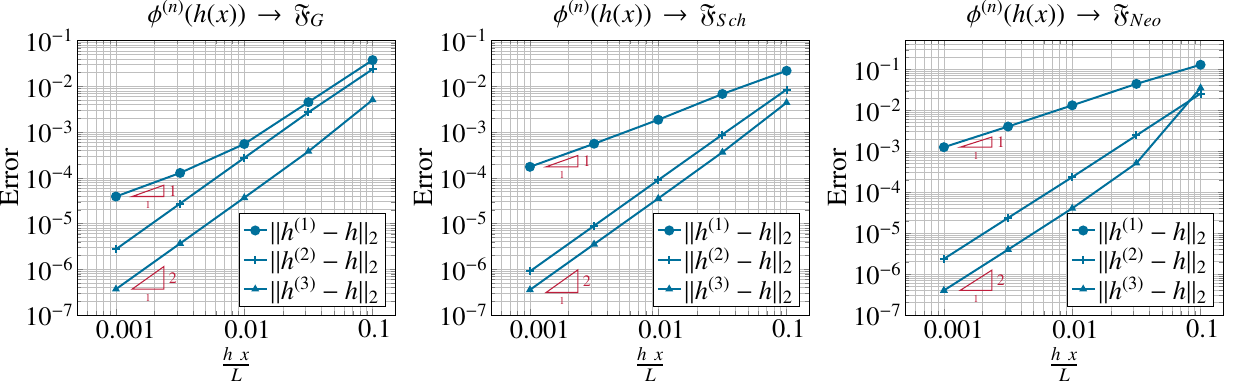
Figure 8. Convergence study for varied offset in the x direction. In each figure, the error in the measured offset h m is plotted against different predefined normalized offsets governed by a linear function h ( x ) . The offsets at x = 0 are set to zero, while the offsets at x = L vary from zero to a maximal value of 0.1 L. The offsets were measured starting from points on different offset surfaces φ ( n ) ( (cid:126) x , h ) = 0 obtained with approximations up to order three. No further improvement is observed when using an approximation method with an order higher than two.